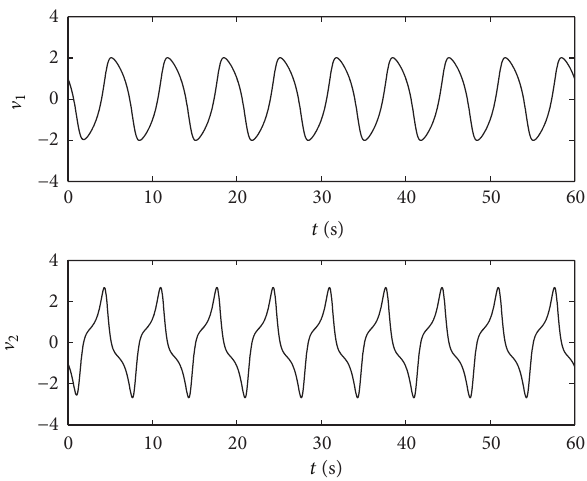
Figure 1: Multiclass nonlinear disturbance inputs.